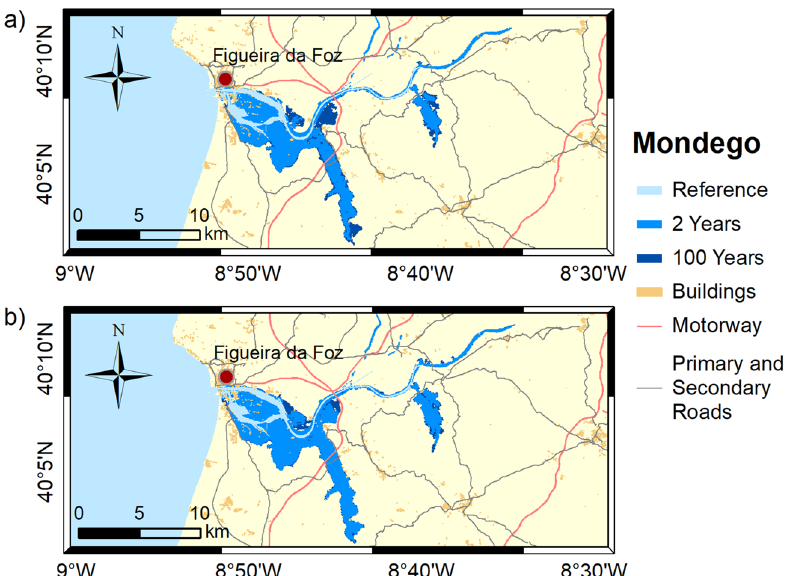
Figure 4. Inundation extents induced by extreme sea levels with return periods of 2 and 100 years on the Mondego estuary in: ( a ) 2046–2065; and ( b ) 2081–2100. These maps were created with Esri ArcGIS 10.8 software (https:// www. esri. com/ en- us/